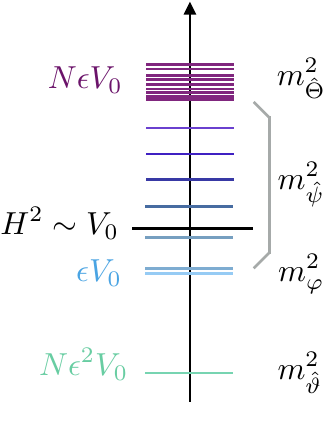
Figure 2 . Mass hierarchies of eq. (3.17) in the deep plateau limit, ’